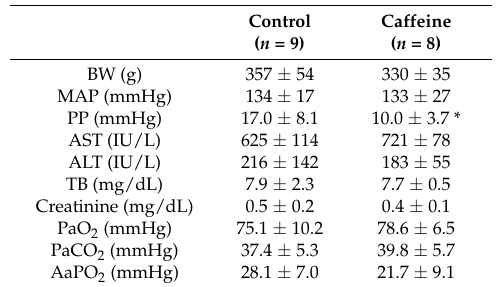
Table 1. Body weight, hemodynamics, biochemistry and arterial blood gas data in cirrhotic rats treated with or without